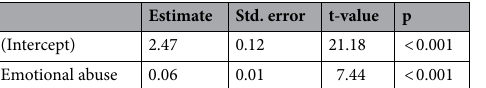
Table 3. Coefficients in the final model of forward stepwise regression to predict personal